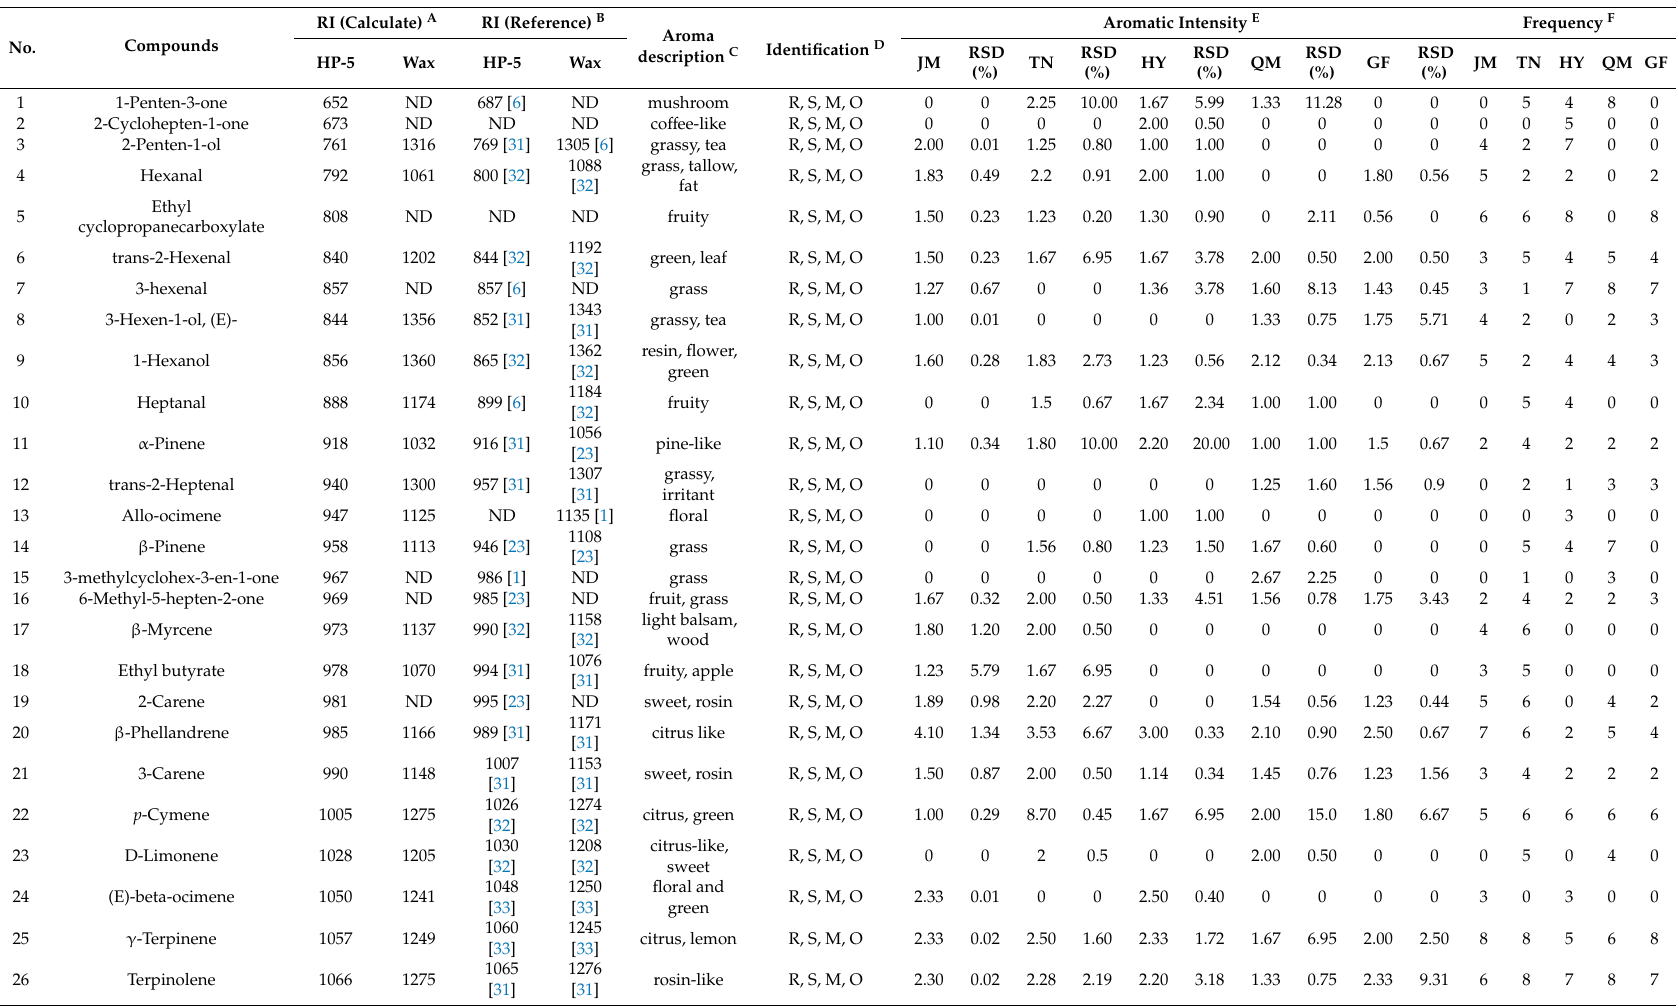
Table 2. GC-O identified aroma-active compounds in mango samples with the method of aromatic intensity and